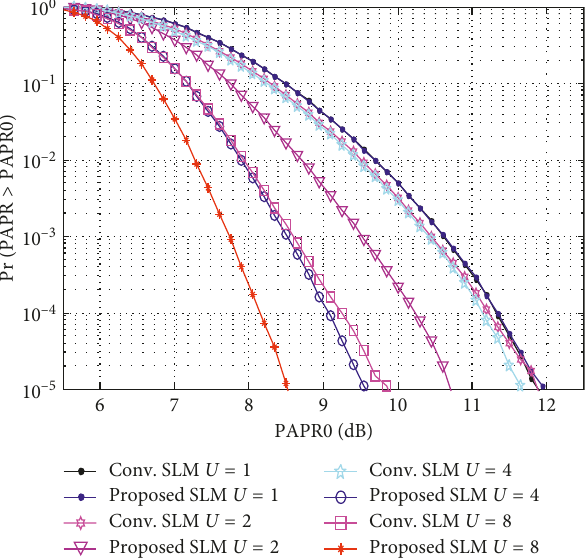
Figure 4: Comparison of SLM given in [5] with the proposed SLM for U � 1, 2, 4, and 8, N � 32, and 4-PSK.